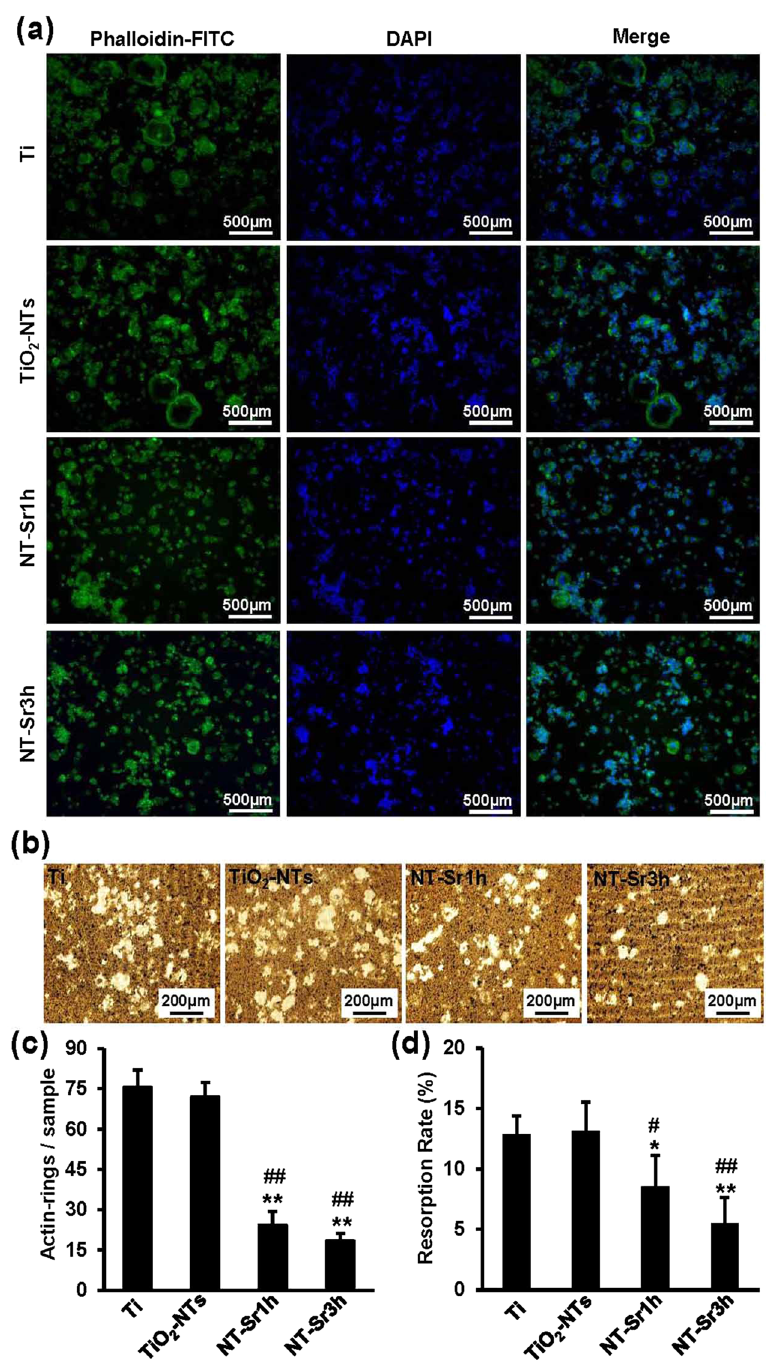
Figure 4. NT-Sr inhibit osteoclast formation and function. ( a , c ) RAW264.7 cells were incubated with 50 ng/mL RANKL on different samples. After culturing for 5 d, the cells were fixed, F-actin ring staining was performed, and the cells were examined by fluorescence microscopy. The number of F-actin rings was quantified. The scale bar represents 500 μ m ( a ). ( b ) RAW264.7 cells were cultured on the Corning Osteo Assay Surface and incubated with 50 ng/mL RANKL for 5 d. The medium was then changed to conditioned medium, and the cells were cultured with 50 ng/mL RANKL for another 3 d. The cells were removed, and the resorbed areas were observed under a scanning electron microscope. The scale bar represents 200 μ m. ( d ) The resorption areas are presented as percentages of the total well areas. * , ** p < 0.05 and 0.01, respectively, compared with the Ti group, and #,## p < 0.05 and 0.01, respectively, compared with TiO 2 -NTs. At least three independent experiments were analysed, and the data are presented as the means ±